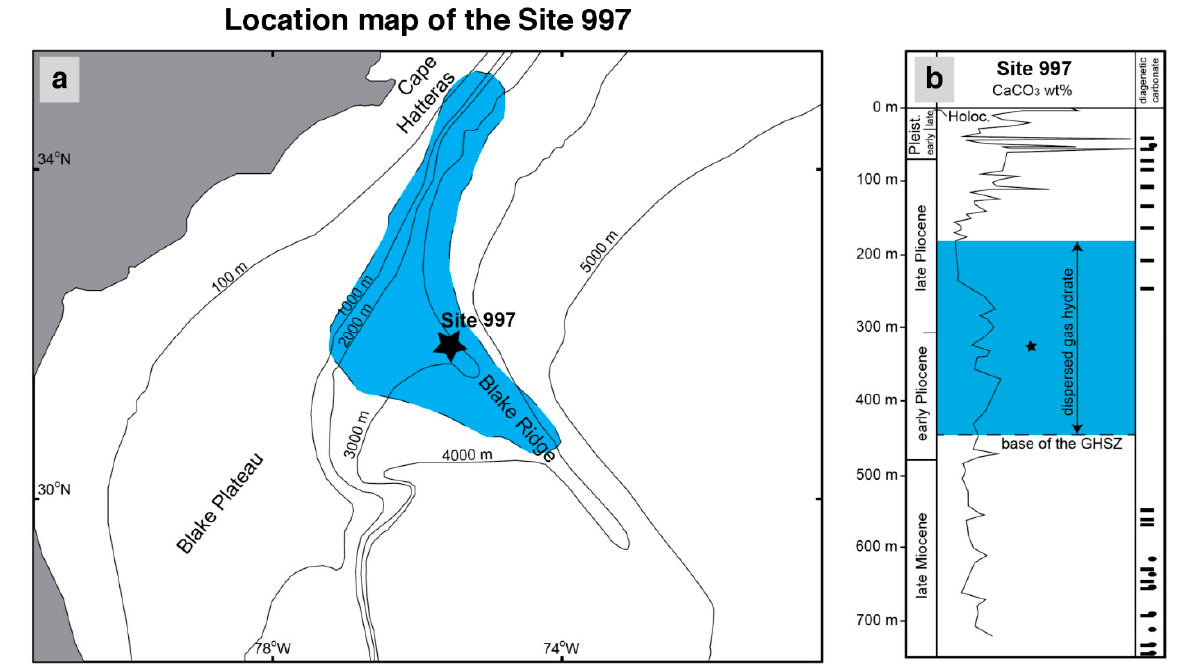
Figure 1. ( a ) Location map of the site 997 drilled during ODP leg 164 in the Blake Ridge area in the North Atlantic US coast. The blue area marks the occurrence of bottom simulating reflections mapped in the area (modified from Fehn et al. [48]). ( b ) Composed core-log for site 997 showing calcium carbonate (wt%) in sediments. Ellipses and bars indicate the position of carbonate nodules and carbonate beds, respectively (modified from Paull et al. [49]). The blue area shows the depth range for the occurrence of dispersed gas hydrate in sediments, and the star shows the location of a 15 cm long gas hydrate piece.